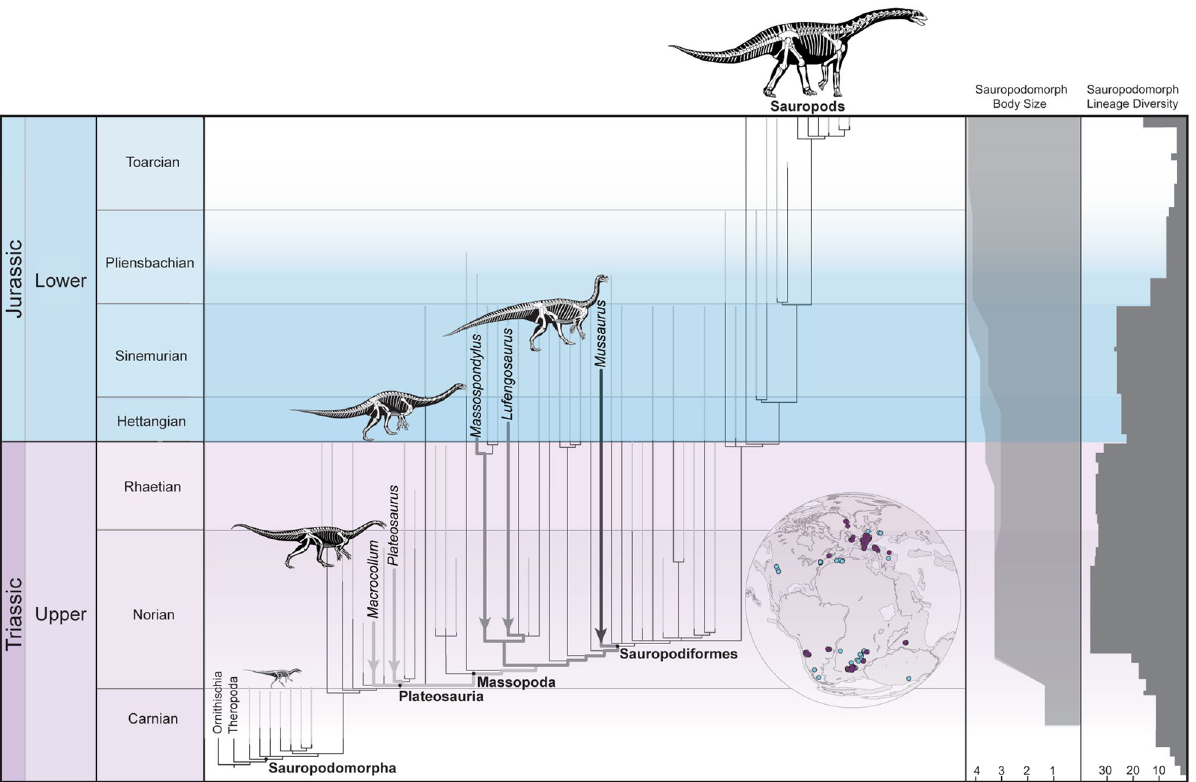
Figure 3. Phylogenetic tree of Sauropodomorpha calibrated against geological time. Thin grey lines on branches represent age uncertainty for terminal taxa. Thick arrows and branches on phylogenetic branches point to the origin of lineages from which behavioural data is discussed in the text. Palaeogeographic reconstruction shows the distribution of Late Triassic (purple) and Early Jurassic (blue) of skeletal remains